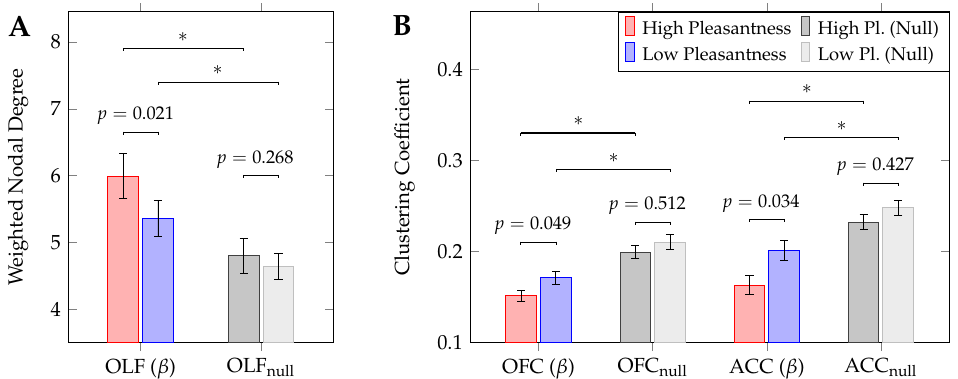
Figure 4. Statistically significant differences in graph theoretic metrics between high- and low pleasantness stimuli (individual regions, paired samples t -tests), including results of graph null- hypothesis testing (*: p < 0.01). Plots show results relating to the weighted nodal degree ( A ) and clustering coefficient ( B ). All events were observed in the beta ( β ) frequency band. FDR-corrected p -values are depicted; error bars show the standard error.